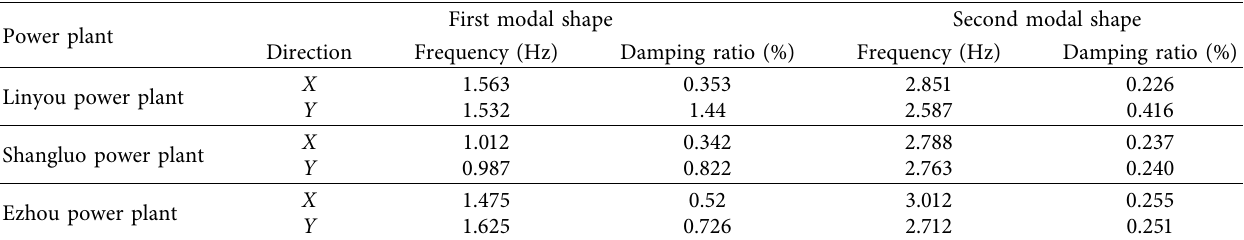
Figure 5: Position of the spring vibration isolators. Table 2: Vibration frequency and damping